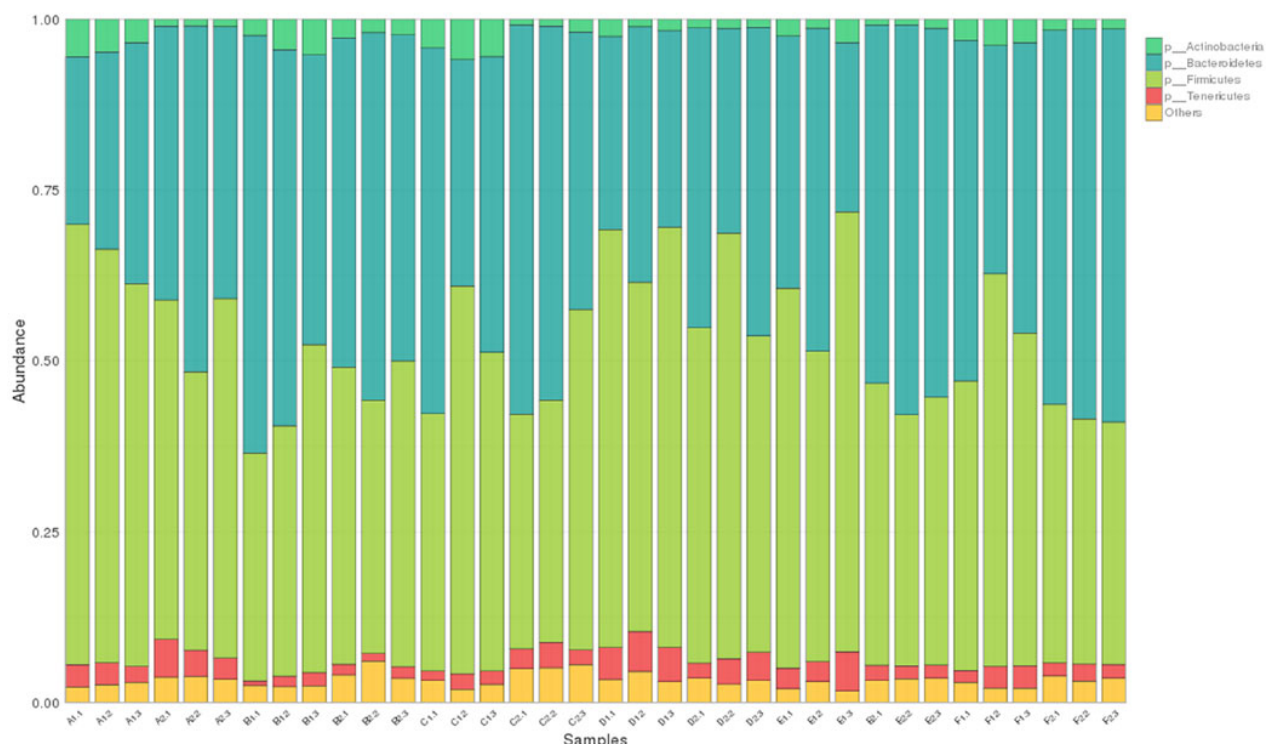
Figure 1. Shannon value and rarefaction curves of OTUs clustered at 97% sequence identity across different samples. A1–F1 represented the addition level of 1–9%, respectively, at day 28; A2–F2 represented the addition level of 1–9%, respectively, at day 56, the same as below.